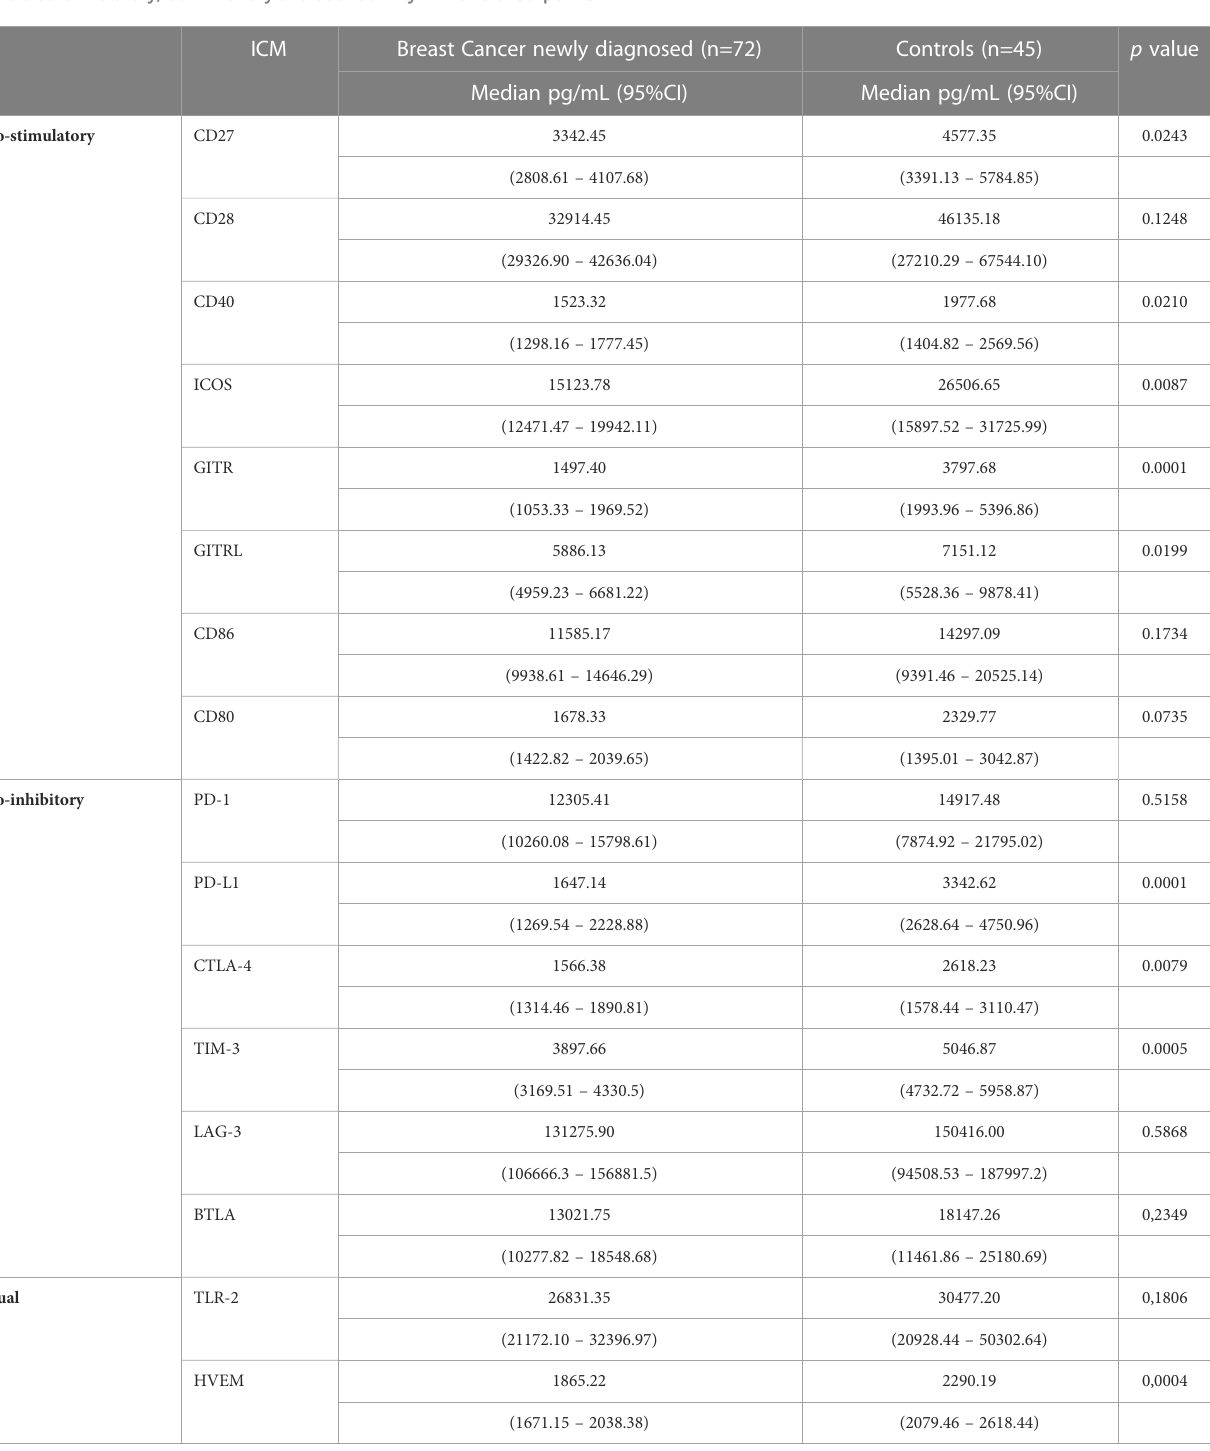
TABLE 2 Comparison between newly diagnosed early breast cancer patients and control subjects with respect to the plasma concentrations of the soluble co-stimulatory, co-inhibitory and dual-activity immune checkpoints.